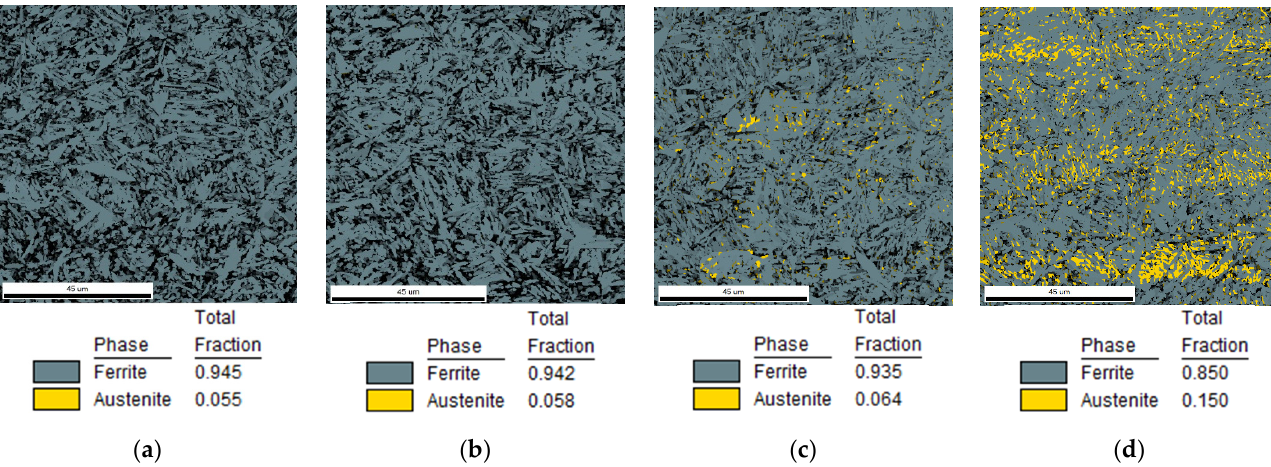
Figure 3. EBSD phase maps (CI > 0.1) of specimens: ( a ) Q quenched to room temperature; ( b ) Q&P 1quenching temperature QT = 175 ◦ C and partitioning temperature PT = 250 ◦ C; ( c ) Q&P 2 QT = 200 ◦ C, PT = 300 ◦ C; ( d ) Q&P 3 QT = 200 ◦ C, PT = 400 ◦ C. The yellow fraction shows the retained austenite in the microstructure (fcc) while the grey shows the ferrite (bcc). This area is not considered in the calculation of phase fractions. The amount of retained austenite is increasing from 5.5% up to 15%. Furthermore, a fine distribution of the retained austenite can be observed in c and d. Interestingly, the increased amount of retained austenite in d must have developed during the partitioning heat treatment in order to experience the same quenching treatment such as c.